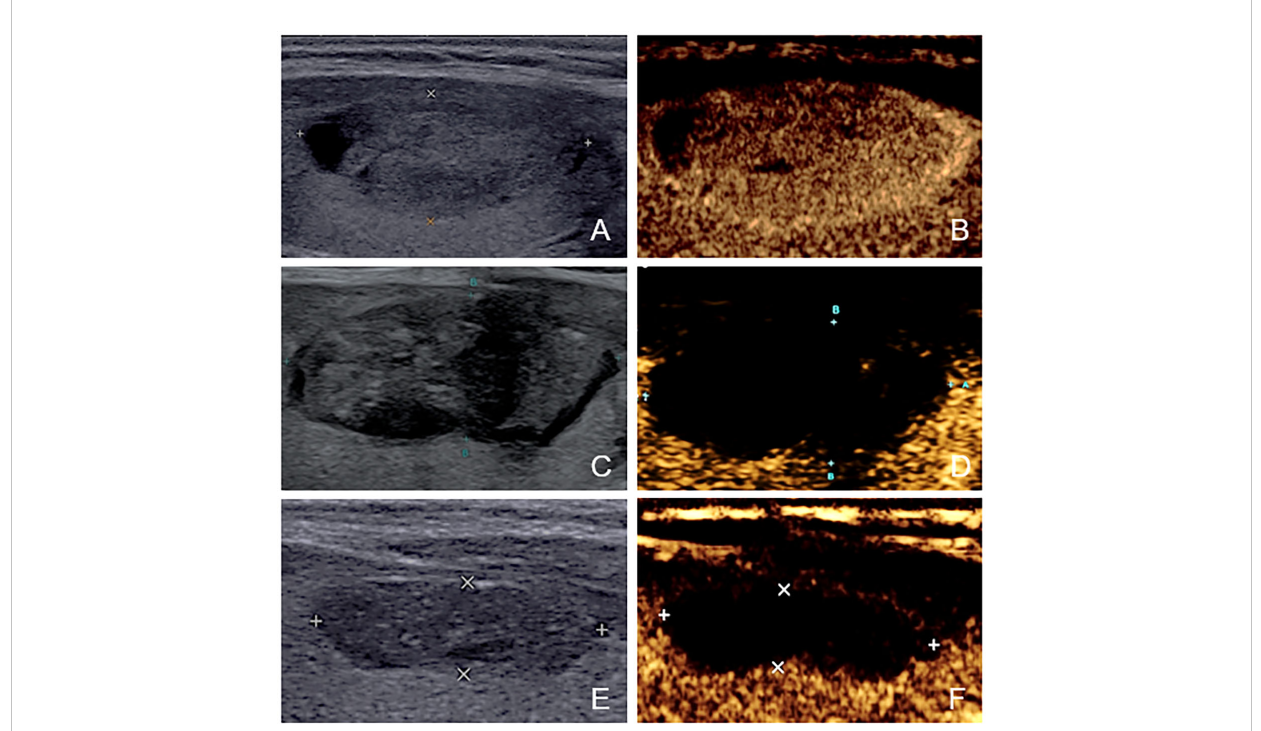
FIGURE 2 The US and CEUS feature of a case in non-residue group — a 41-year-old female. (A, B) Before ablation, the initial volume of the target nodule was 3.22 ml. There was no septum inside the nodule. Her residue rate according to the nomogram was 8.1%. (C, D) At one-month follow-up, no enhanced area was observed at the ablative margin under CEUS. (E, F) At four-month follow-up, the volume was 0.62ml, and VRR was